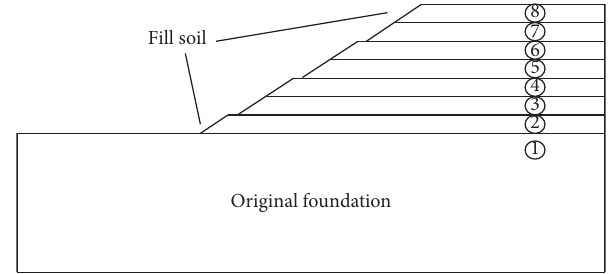
Figure 4: The diagram of construction conditions of multistage fill